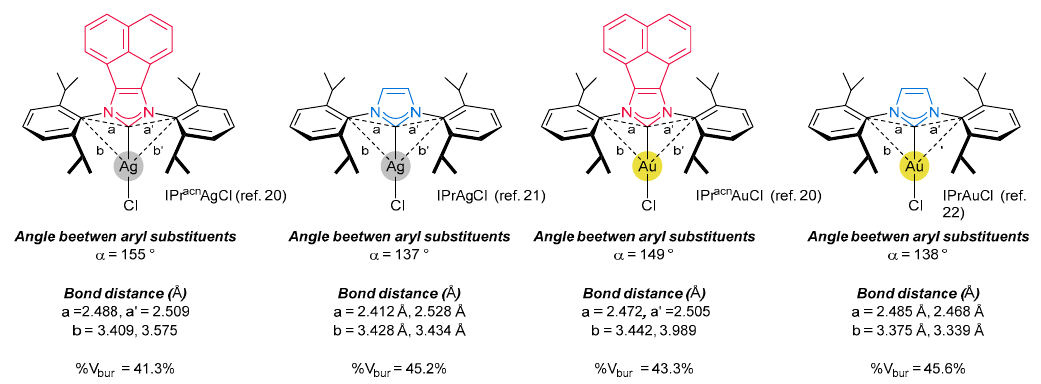
Figure 3. Angle between N-wingtip substituents and the selected bond distance, based on crystallographic data. IPr acn AgCl [20], IPrAgCl [21], IPr acn AuCl [20], IPrAuCl [22].